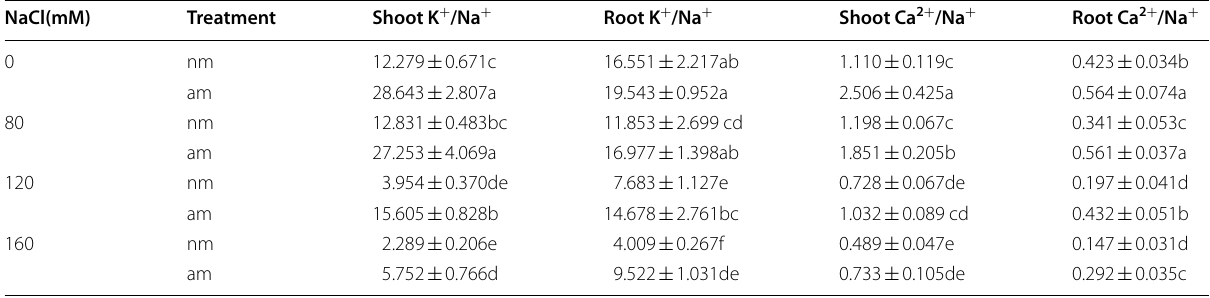
Table 2 Effects of salt and AMF compound inoculants on shoot K + /Na + ratio, root K + /Na + ratio, shoot Ca 2 + /Na + ratio, root Ca 2 + /Na + ratio in Oryza sativa